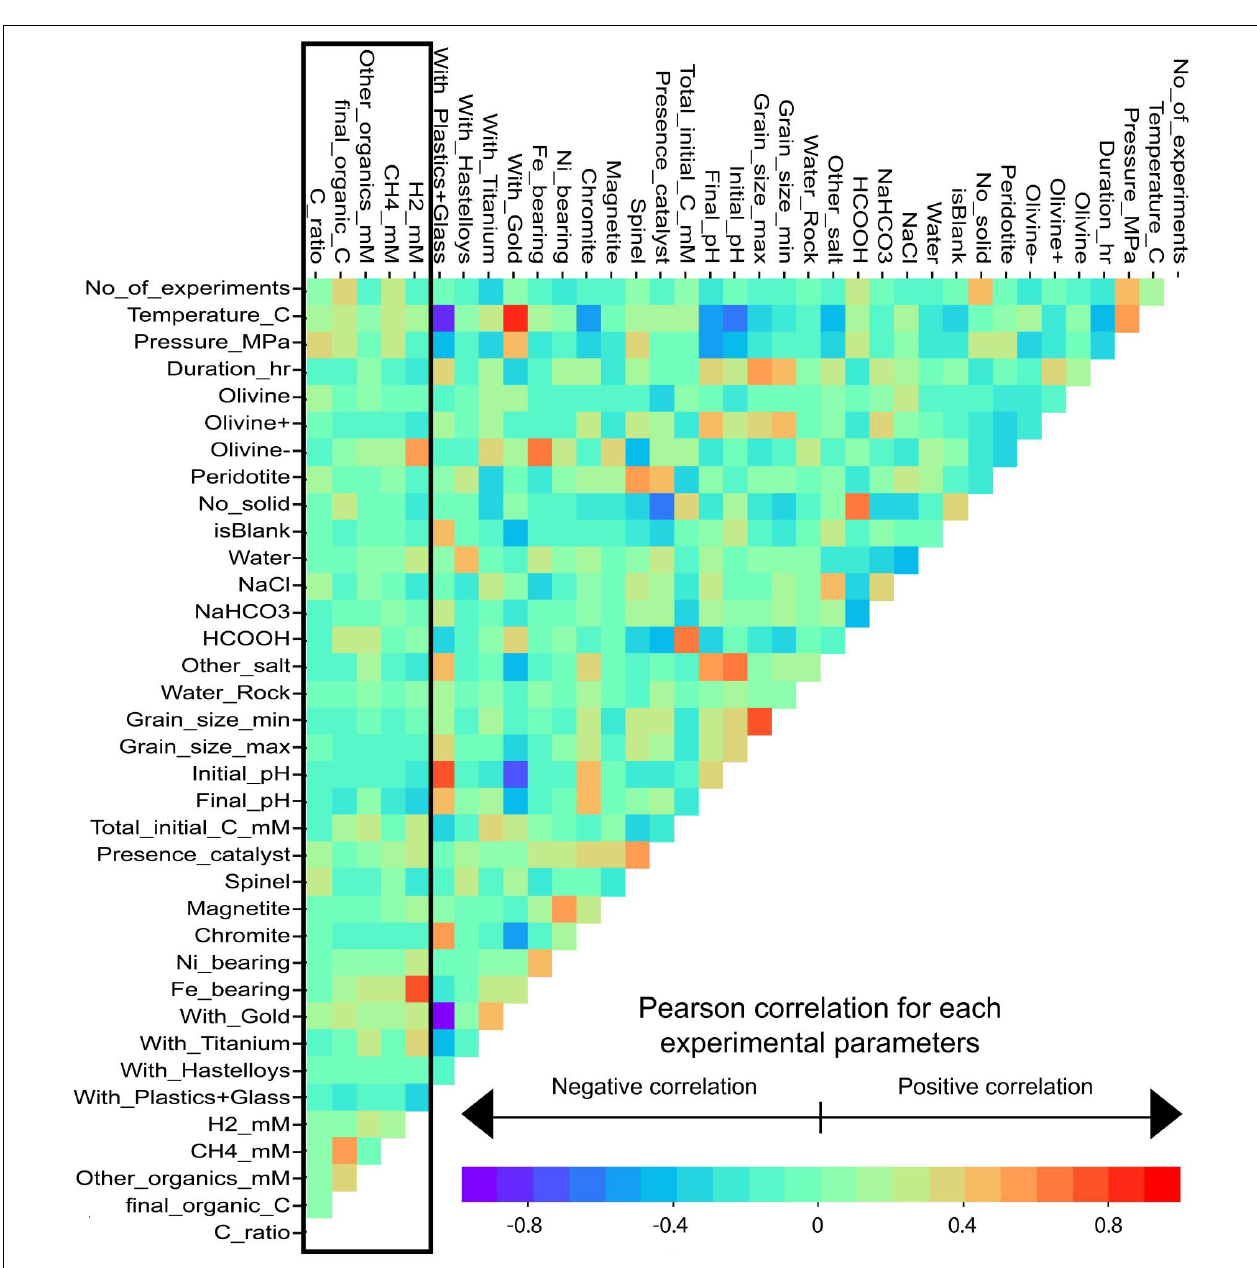
FIGURE 4 | Pearson correlation coefficient matrix between all parameters analyzed in the dataset. Warm and cold colors show positive and negative correlation, respectively. The black rectangle across the first five columns highlights the five important experimental